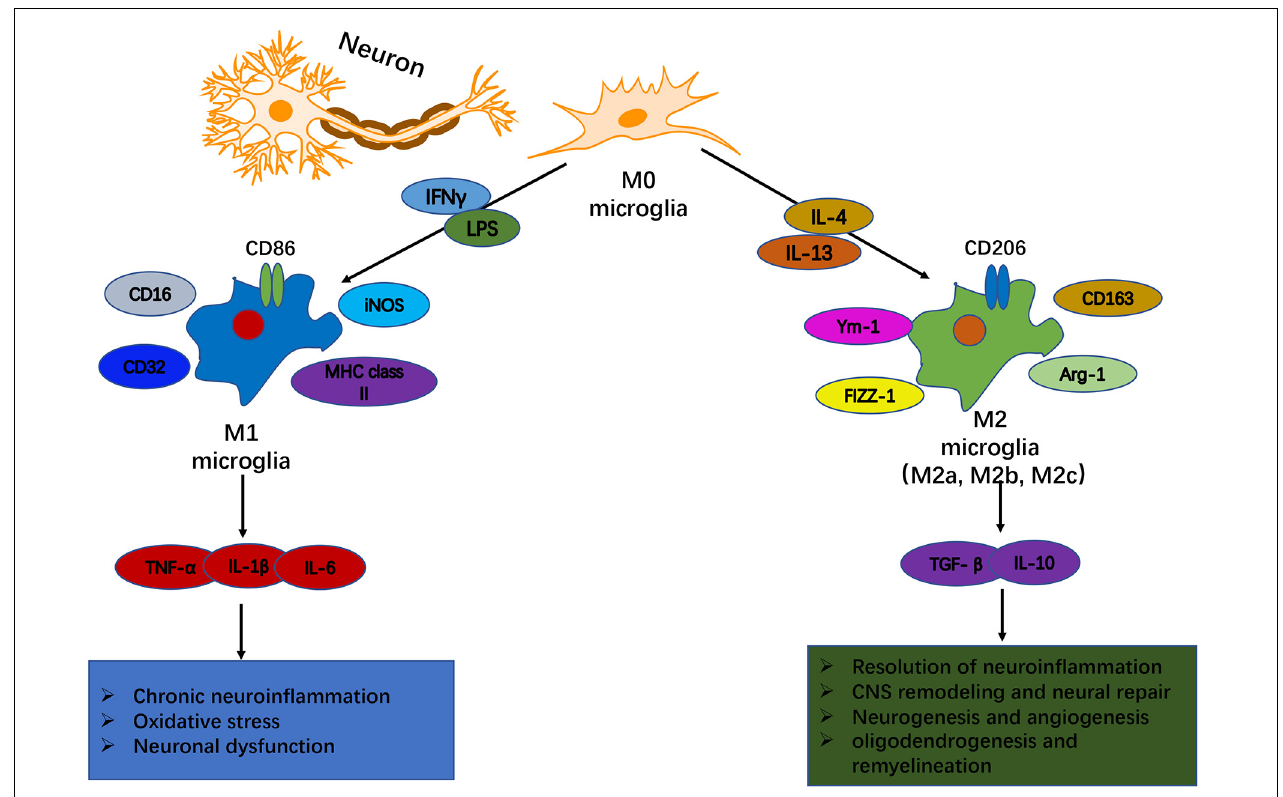
FIGURE 1 | Heterogeneity of microglia: phenotypic and functional diversity. In response to disturbance of brain homeostasis like injury or disease, microglia can become polarized toward M1-like and M2-like activation states that can have distinct roles in neurodegeneration and tissue repair. An environment rich with the classical pro-inflammatory stimuli, such as IFN- γ and LPS, promotes the polarization of resting microglia into an M1 phenotype. M1-like microglia are characterized by upregulated expression of phenotypic protein markers such as IL-1 β , TNF α , IL-6, and iNOS. They release pro-inflammatory cytokines, chemokines and free radicals that impair brain repair and contribute to chronic neuroinflammation, oxidative stress and long-term neurological impairments. In contrast, a neuroinflammatory environment rich in anti-inflammatory IL-4 or IL-13 drives the development of an M2 phenotype. M2-like microglia upregulate protein markers such as CD206, CD163, FC γ R, arginase 1, Ym-1, and TGF β . M2-like microglia release anti- inflammatory cytokines, neurotrophic factors and proteases, and they have increased phagocytic activity. M2-like microglia promote immunosuppression and resolution of M1-mediated neuroinflammation, and participate in CNS remodeling and repair by modulating neurorestorative processes such as neurogenesis, angiogenesis, oligodendrogenesis and